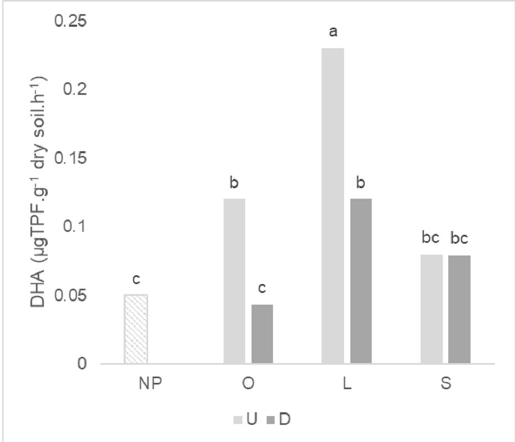
Figure 5. Graph of interactions between previous plant type and soil disturbance in dehydrogenase (DHA) activity after wheat growth. NP: wheat that grew with no previous plants; O: wheat that grew after O. compressus ; L: wheat that grew after L. rigidum ; S: wheat that grew after S. gallica ; U: soil undisturbed and D: soil disturbed. Values sharing different letters indicate significant differences between treatments at the 5% level (Tukey’s t -test).